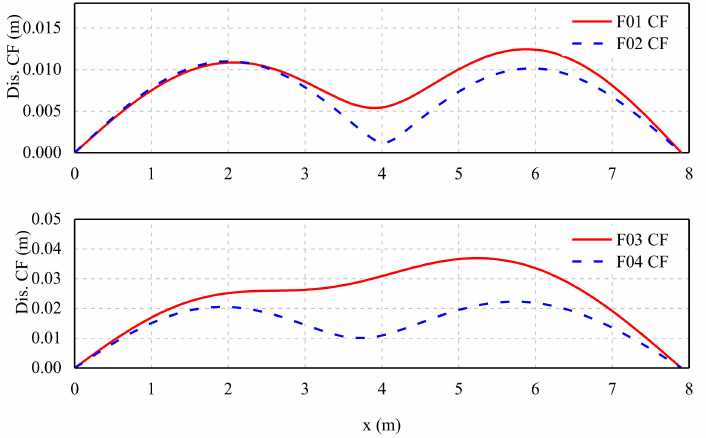
Figure 8. The RMS values of displacement under vortex-shedding frequency of buoyancy modules (uniform flow 1.6